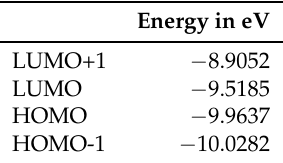
Table 2. Myoglobin energies near the HOMO–LUMO gap. The energies have been calculated with the semiempirical extended Hückel method implemented in the YaEHMOP package http://yaehmop.